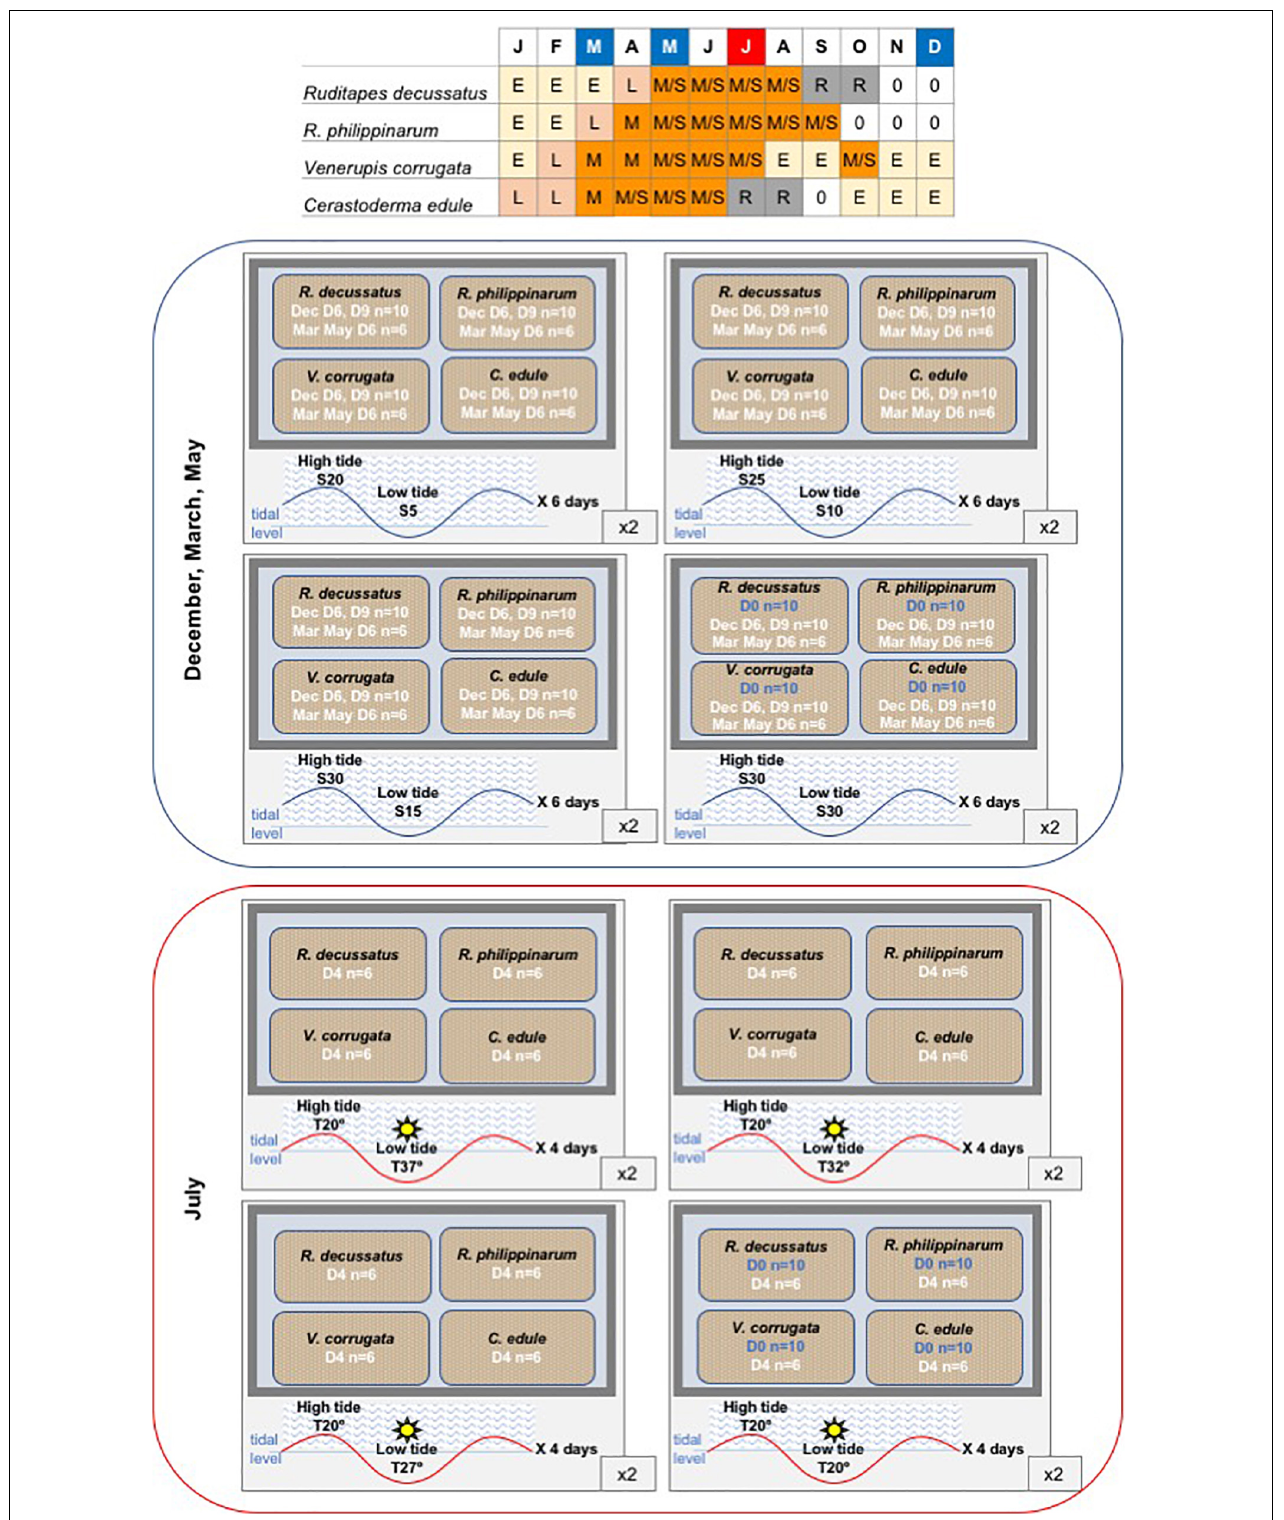
FIGURE 2 | Design of the mesocosm experiment. Each 480 L tank with four 16 L tanks inside filled with sediment, each one with one species. Table represents the gametogenic cycle of the four studied species along the year. Months at which low salinity experiments were carried out are marked in blue and month at which heatwave experiment was run is marked in red. E, early gametogenesis; L, late gametogenesis; M, ripe; S, spawning; R, resorption; 0, sexual rest.